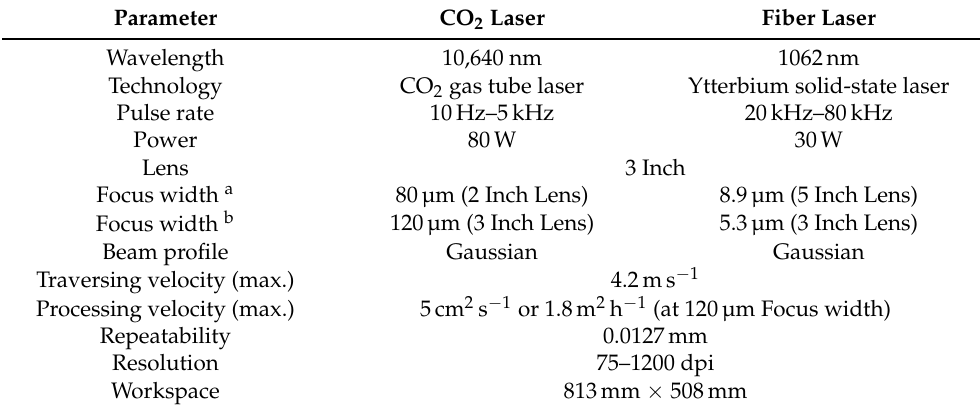
Table 2. Technical data of the used cutting and engraving laser Epilog Fusion Pro 32